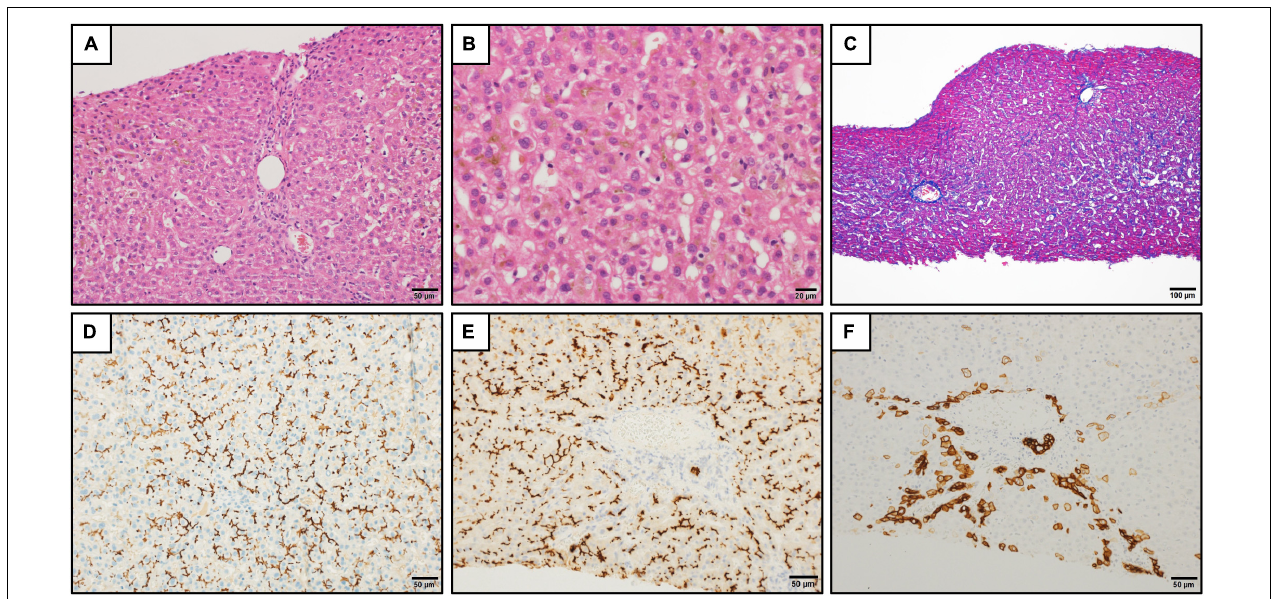
FIGURE 1 | Histopathologic findings in the liver. (A) Liver tissue showed no significant lobular architecture (hematoxylin and eosin staining). Scale bar represents 50 µ m. (B) Cholestasis was observed in the hepatocytes, Kupffer cells, and bile canaliculi at zones 2 and 3 (hematoxylin and eosin staining). Scale bar represents 20 µ m. (C) There was no significant fibrosis (Azan staining). Scale bar represents 100 µ m. (D–F) Immunohistochemistry for bile salt export pump (D) , CD10 (E) , and keratin 7 (F) . The strong expression of bile salt export pump and CD10 were observed at the canalicular membrane (D,E) . The keratin 7 expression was found in the